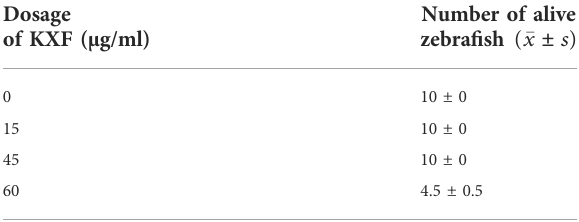
TABLE 1 Toxicity analysis of KXF in zebra fi sh. Dosage of KXF ( μ g/ml)